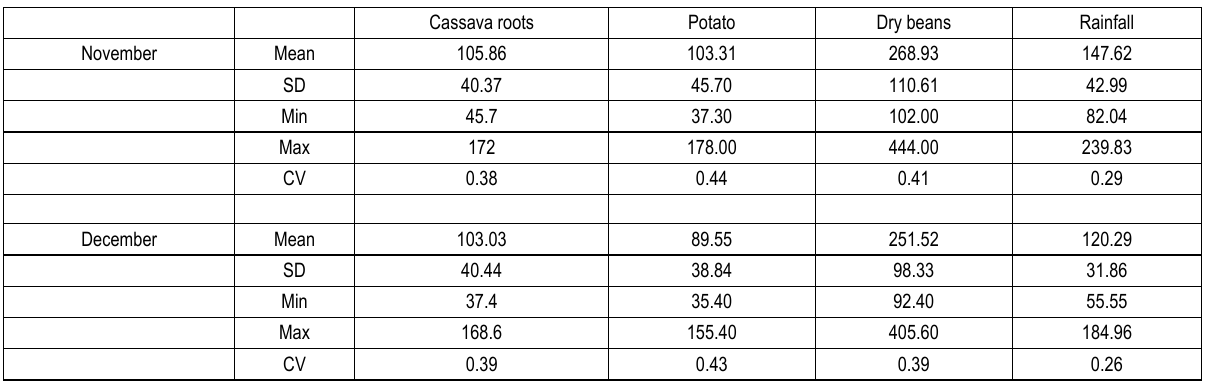
Table 1 (cont.). Descriptive statistics on key variables of interest in the study (real prices are expressed in Rwandan Francs; rainfall is in millimetres) Cassava roots Potato Dry beans